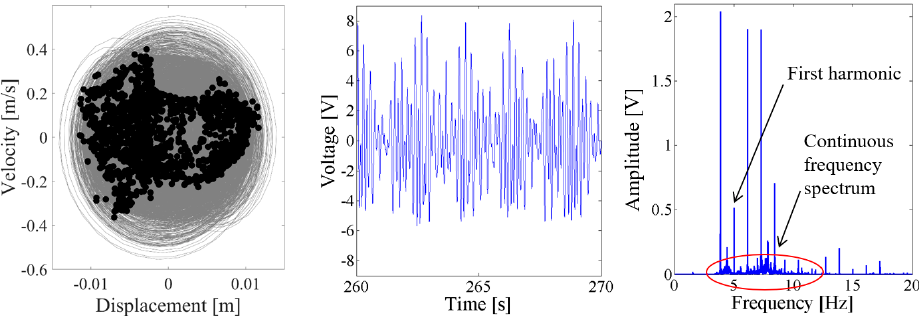
Figure 16. Dynamic responses of the coupled harvester-1 for the excitation level of 0.6 g.